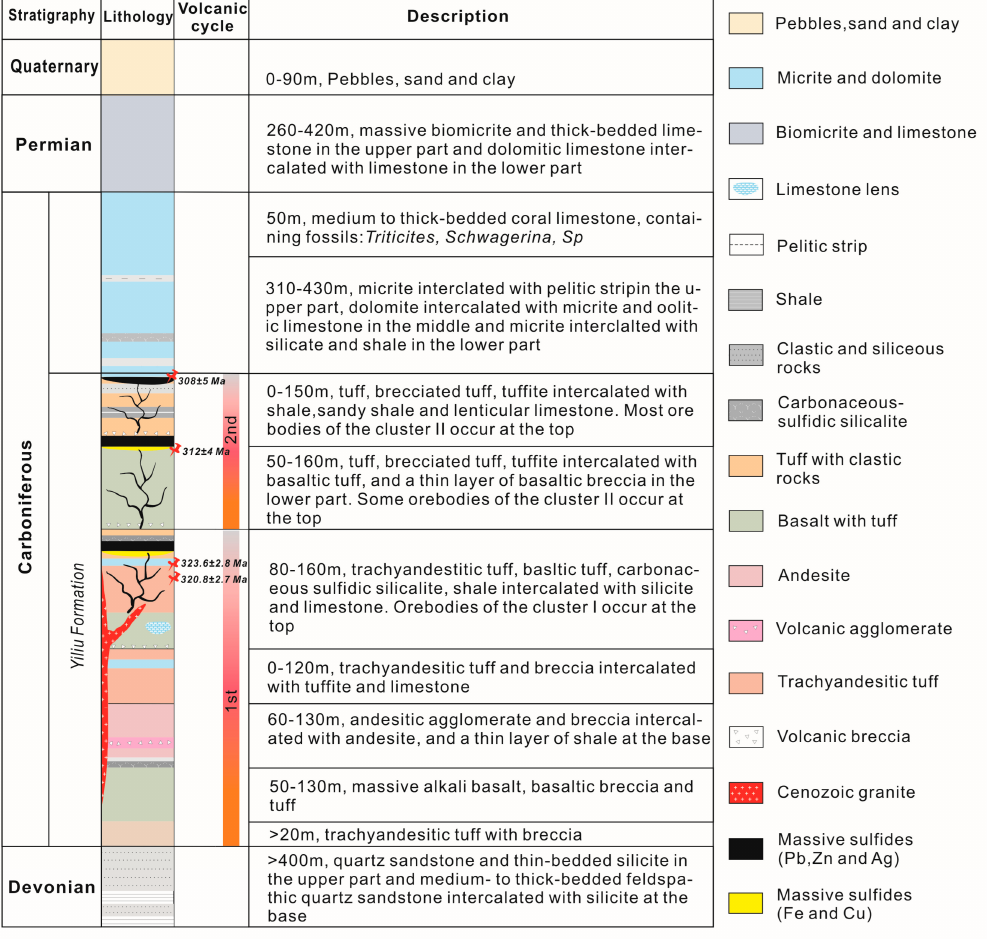
Figure 4. Lithostratigraphic column of the Laochang deposit. Note that the Carboniferous volcanic-sedimentary cycles comprise eight lithologic layers that formed during two volcanic cycles. (modified from Mo et al. [13] and Ye et al.